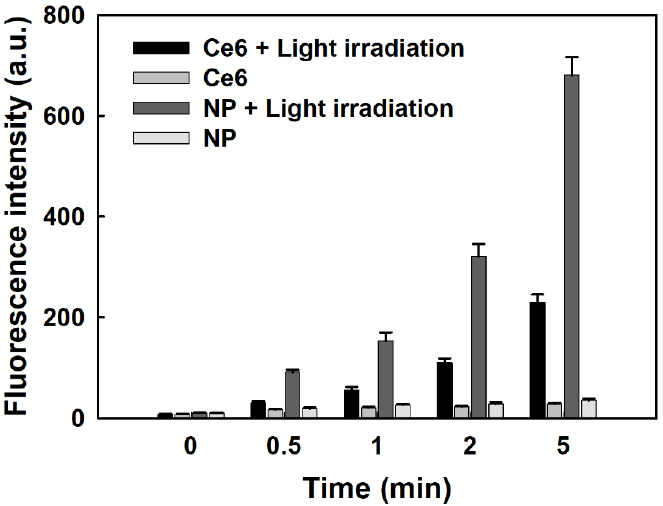
Figure 5. SO generation from free Ce6 and nanophotosensitizers in the absence or presence of light irradiation (664 nm, n = 4). Arbitrary units = (a.u.). NP= nanophotosensitizers. The results are the average ± standard deviation (s.d.) from three separate experiments.